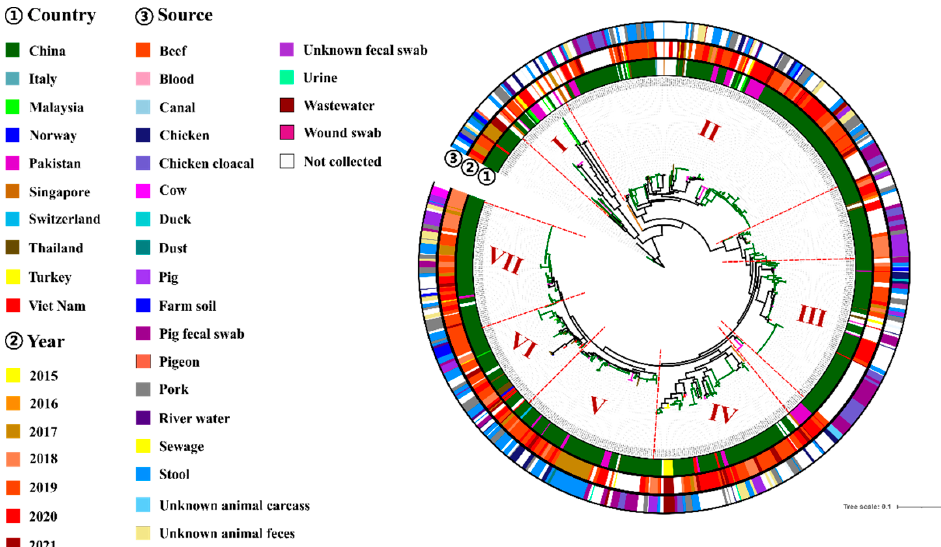
Figure 5. Phylogenetic tree of tet (X4)-producing E. coli genomes from different countries. Circle ① depicts isolate isolation countries; circle ② denotes the distribution of years; circle ③ denotes sample sources. The detailed information in circles ① – ③ using various colors is shown in the key. Lineages I, II, III, IV, V, VI, and VII were shown in the figure.